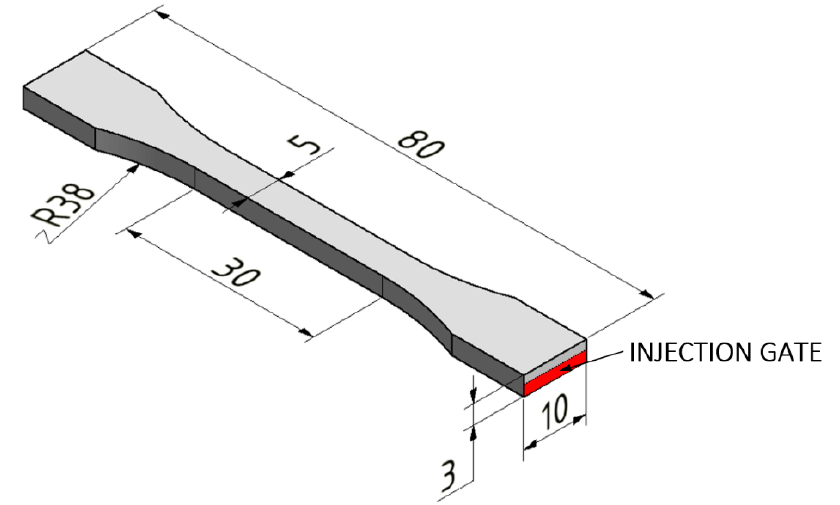
Figure 1. Shapes and dimensions of tested specimens. Adapted from [38], MDPI, 2022.